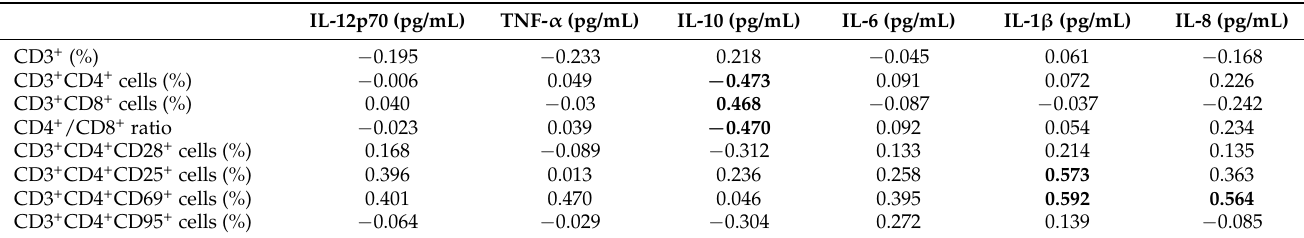
Table 4. Correlations between immunological parameters in TRD